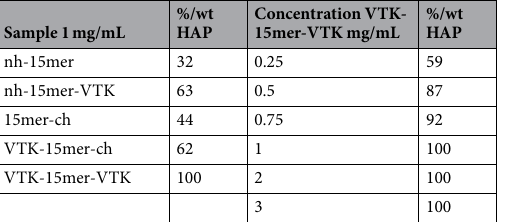
Table 3. Previously published data on silk-fusion proteins containing the CaP(V) (or VTK) binding peptide with new quantification method applied 18 . nh refers to His tag at N-terminus of protein; ch refers to His tag at